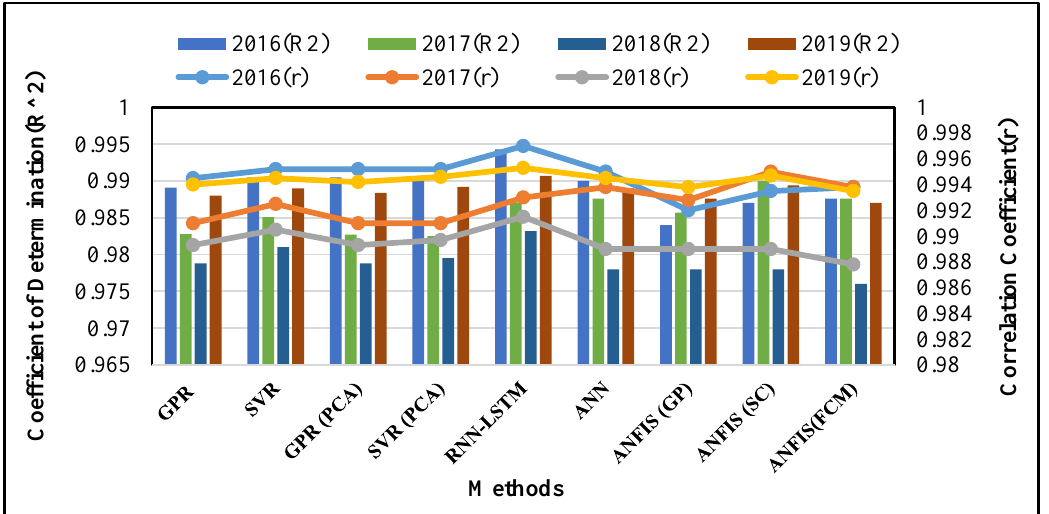
Figure 11. Comparison of RNN-LTSM test results of r and R 2 for m-si with other techniques over the period (2016–2019).